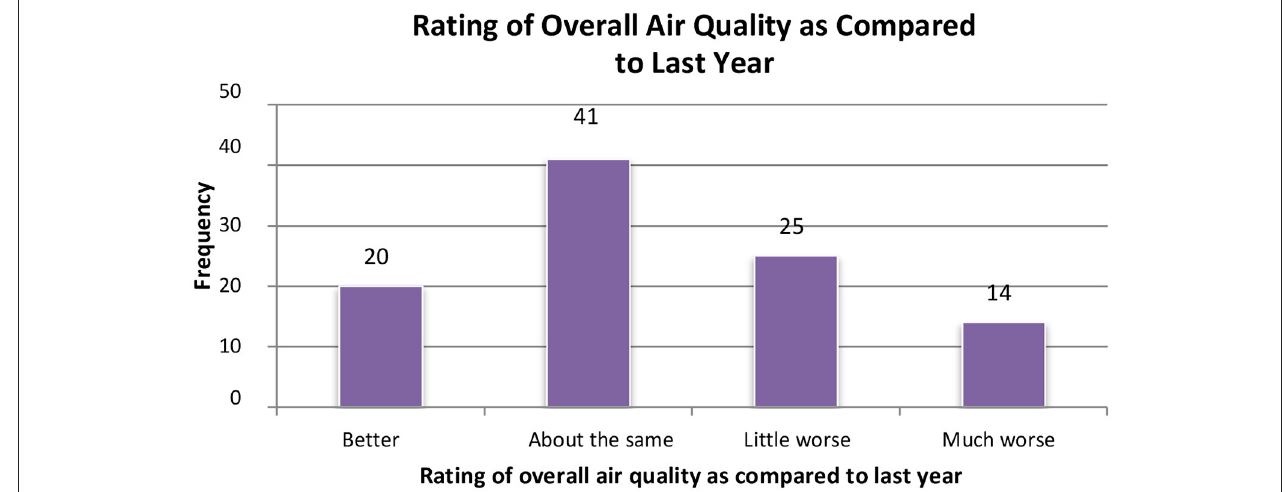
FIGURE 17 | Rating of the overall air quality compared with last year.